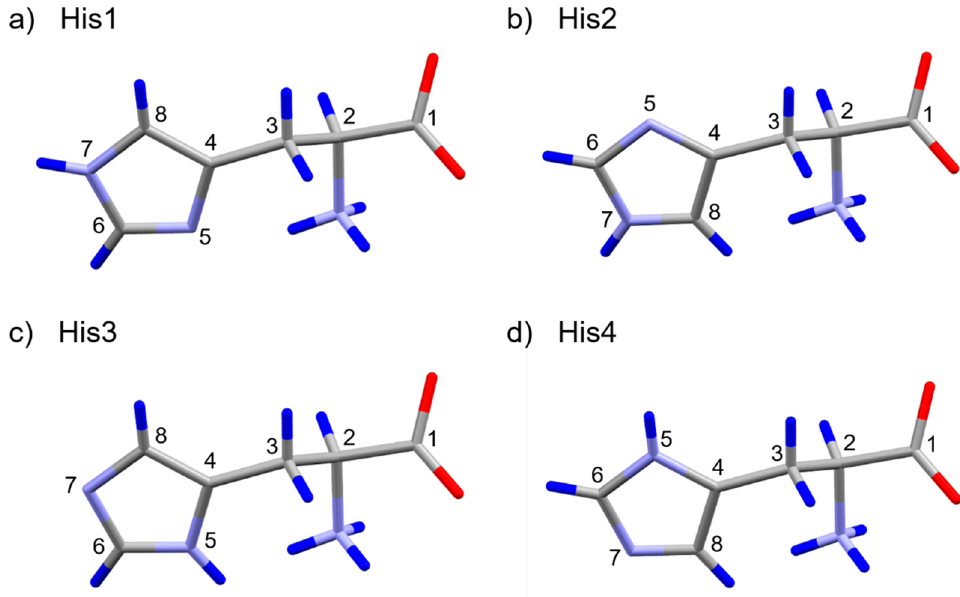
Figure 2. Four candidate structures of monoclinic L -histidine (His) derived from microED analysis: ( a ) His1, ( b ) His2, ( c ) His3, and ( d ) His4. The dark blue, grey, light blue, and red atoms denote H, C, N, and O, respectively. His1(3) differ from His2(4) by the positions of C and N atoms on the imidazole ring. His1(2) differ from His3(4) by the position of H atom on a N atom on the imidazole ring. The H, C and N atoms are numbered.